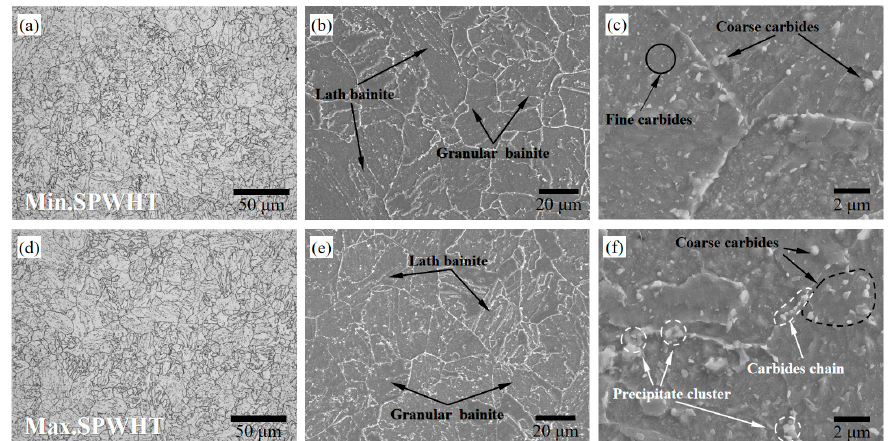
Figure 4. ( a ) Metallographic picture, ( b ) low-magnification picture, and ( c ) high-magnification picture of the microstructure of the 2.25Cr1Mo0.25V steel in Min.SPWHT; ( d ) Metallographic picture, ( e ) low-magnification picture, and ( f ) high-magnification picture of the microstructure of the 2.25Cr1Mo0.25V steel in Max.SPWHT.